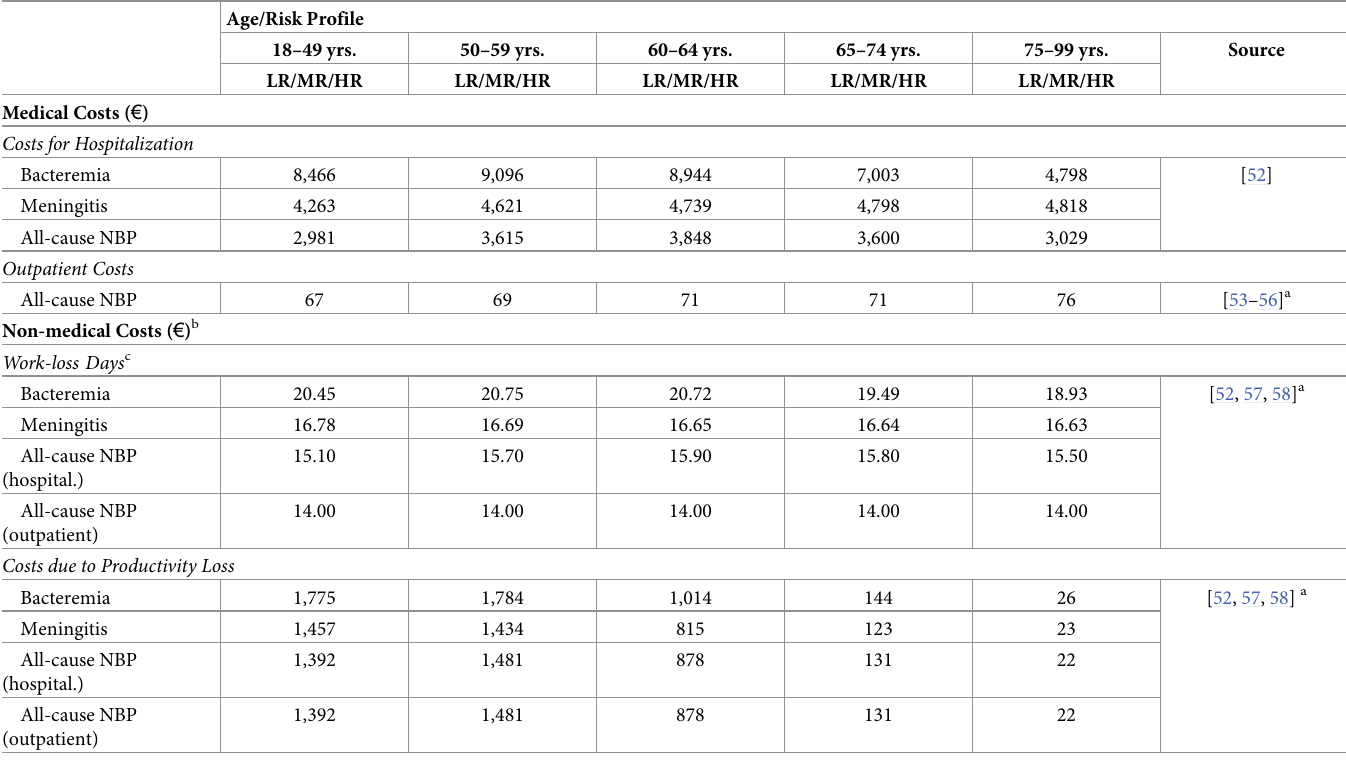
Table 4. Age and risk level specific medical and non-medical costs b